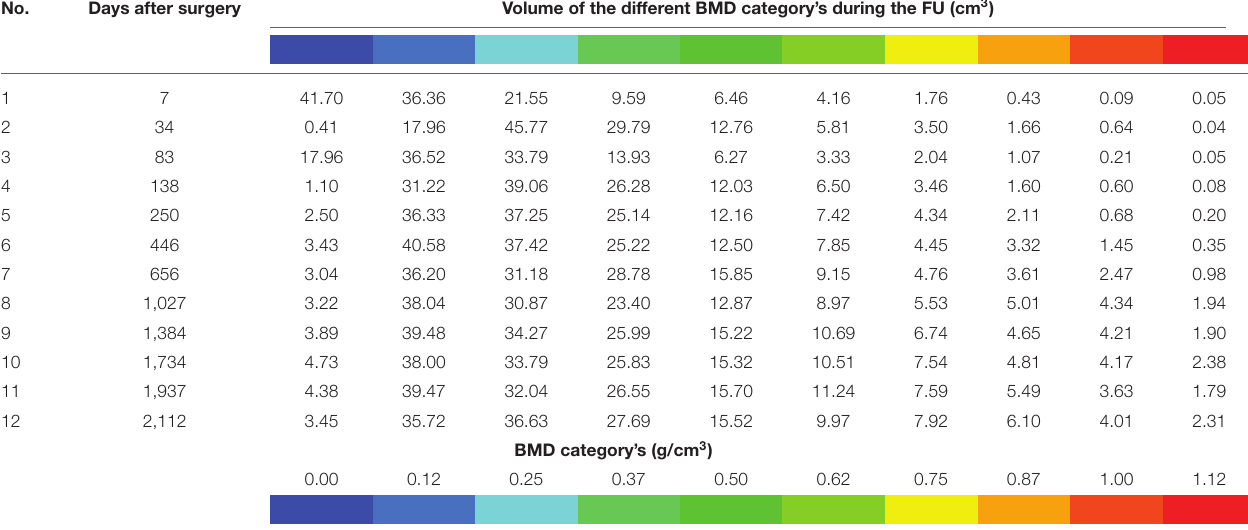
TABLE 3 | Volumetric change of the voxel groups corresponding to the BMD categories. No. Days after surgery Volume of the different BMD category’s during the FU (cm 3 )